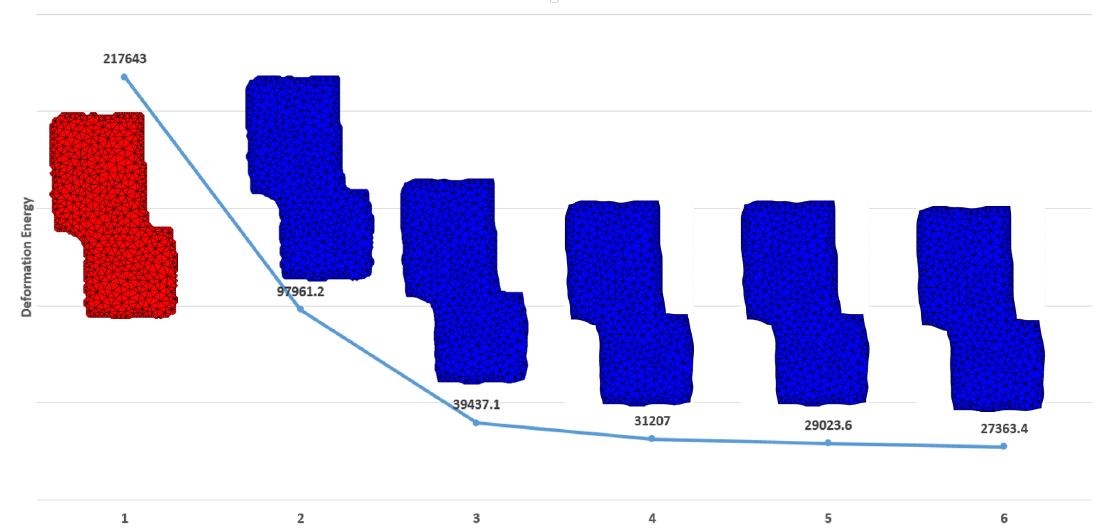
Figure 5. Optimization of the energy E deform . While the energy drops at each iteration, the contour is gradually aligned to its assigned target direction in Section 2.3.